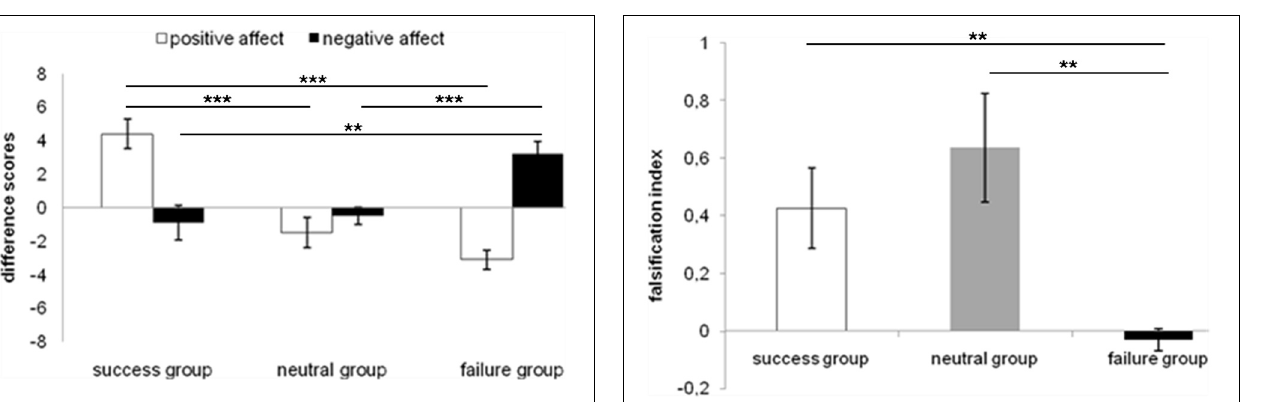
FIGURE 2 | Difference scores (t 2 - t 1 ) for the emotion induction of Experiment 1 for each group. ∗∗ p ≤ 0 . 01, ∗∗∗ p ≤ 0 . 001. FIGURE 3 | Falsification index (ranging from − 2 to 2) for the WSTs for